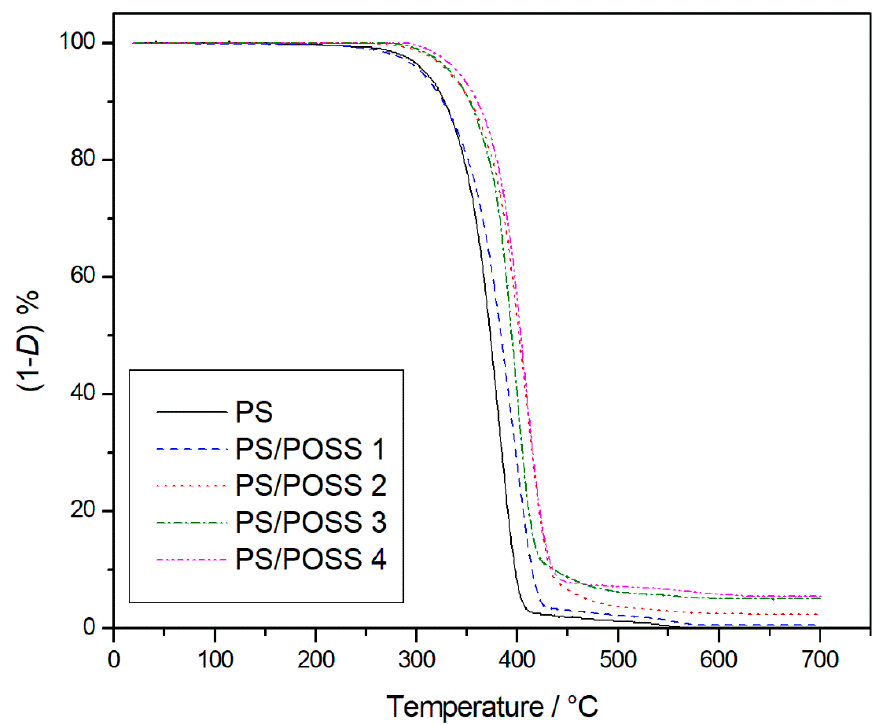
Figure 9. Thermogravimetric curves, in an oxidative atmosphere, for PS and prepared nanocomposites.